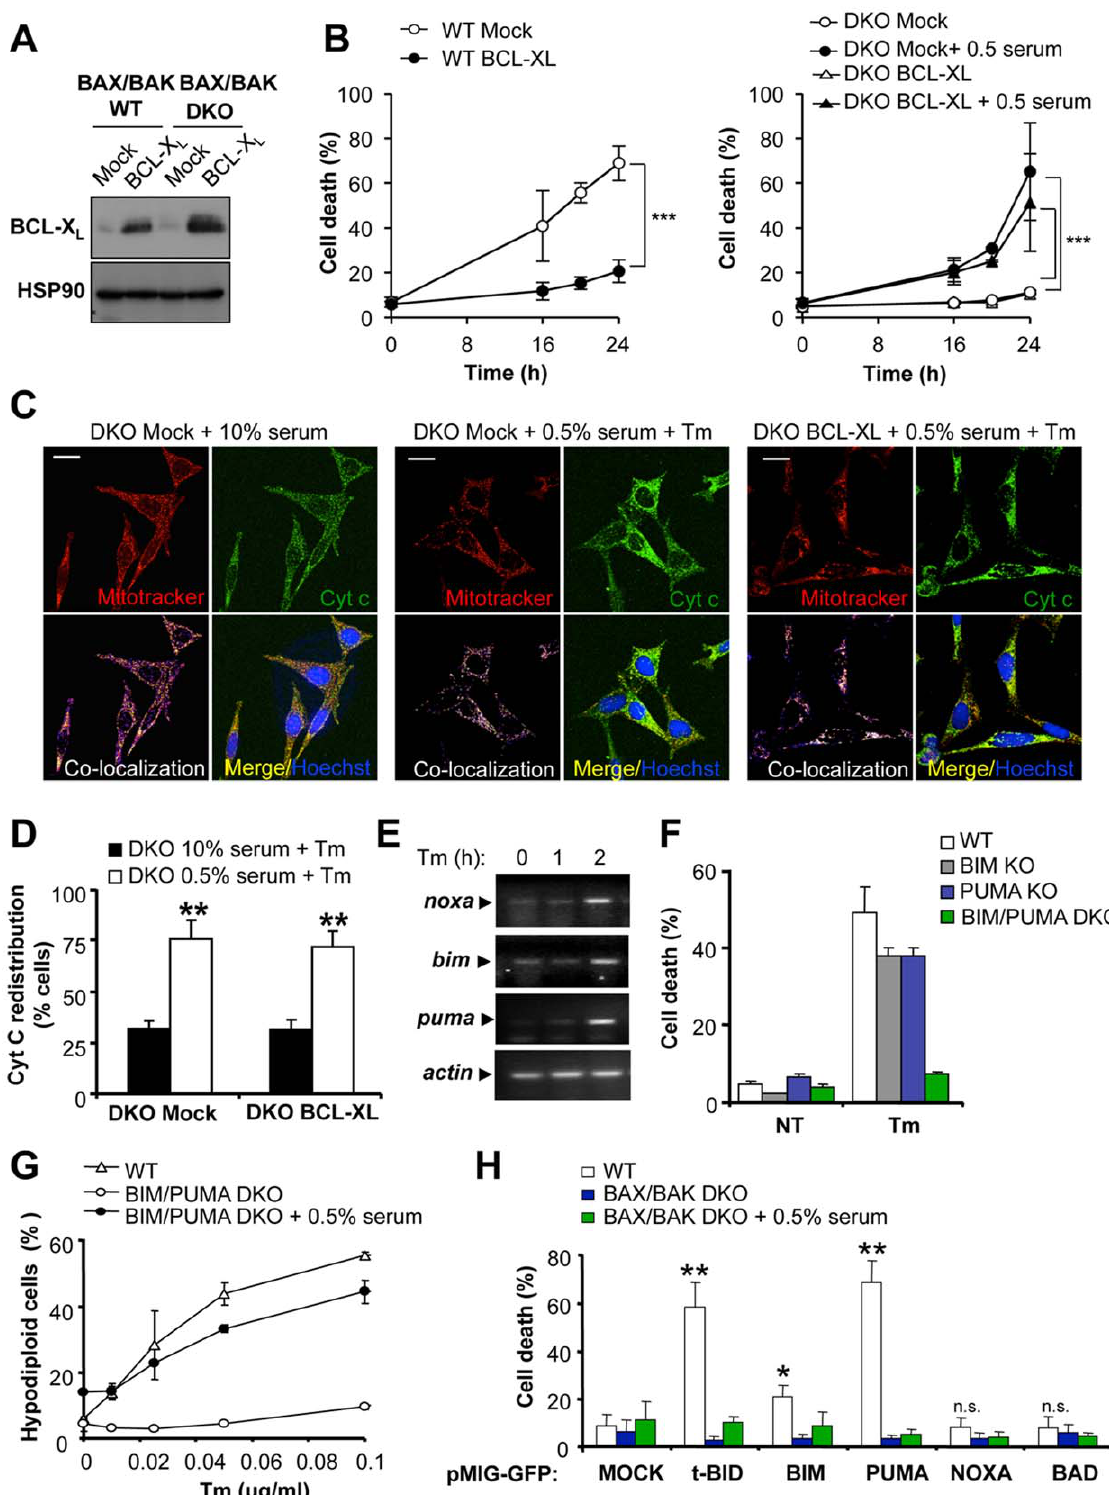
Figure 4. BAX and BAK-independent cells death induced by ER stress and serum withdrawal is not affected by BCL-X L overexpression or by BH3-only proteins. ( A ) WT and BAX/BAK DKO MEFs were stably transduced with retroviruses expressing human BCL-X L or empty vector (Mock) and the expression levels of BCL-X L was evaluated by Western blot analysis. As loading control, HSP90 levels were determined. ( B ) Then the susceptibility of cells presented in (A) to cell death was assessed after treatments with 10 m g/ml Tm in cells pretreated in cell culture media containing 0.5% serum for 2 h or grown with regular cell culture media. Cell death was monitored by PI staining and FACS analysis at 16, 20 and 24 h. Mean and standard deviation is presented of three independent experiments. Two-way ANOVA was used to analyze statistical significance